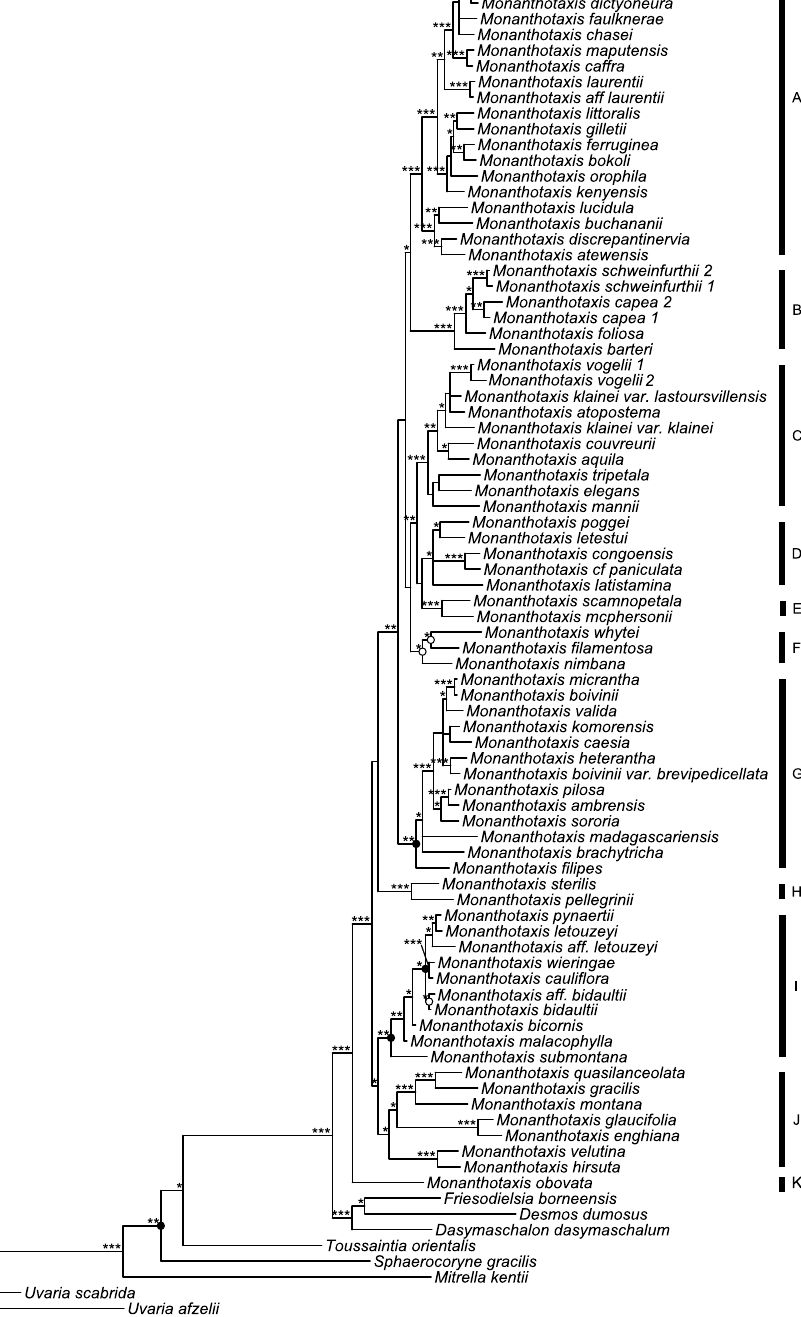
Figure 2. Phylogeny of Monanthotaxis . *** Strong node support, ** moderate node support, * = weak node support. Nodes indicated with black and white dots are strongly and moderately supported, respectively, after removing species for which only a few markers were